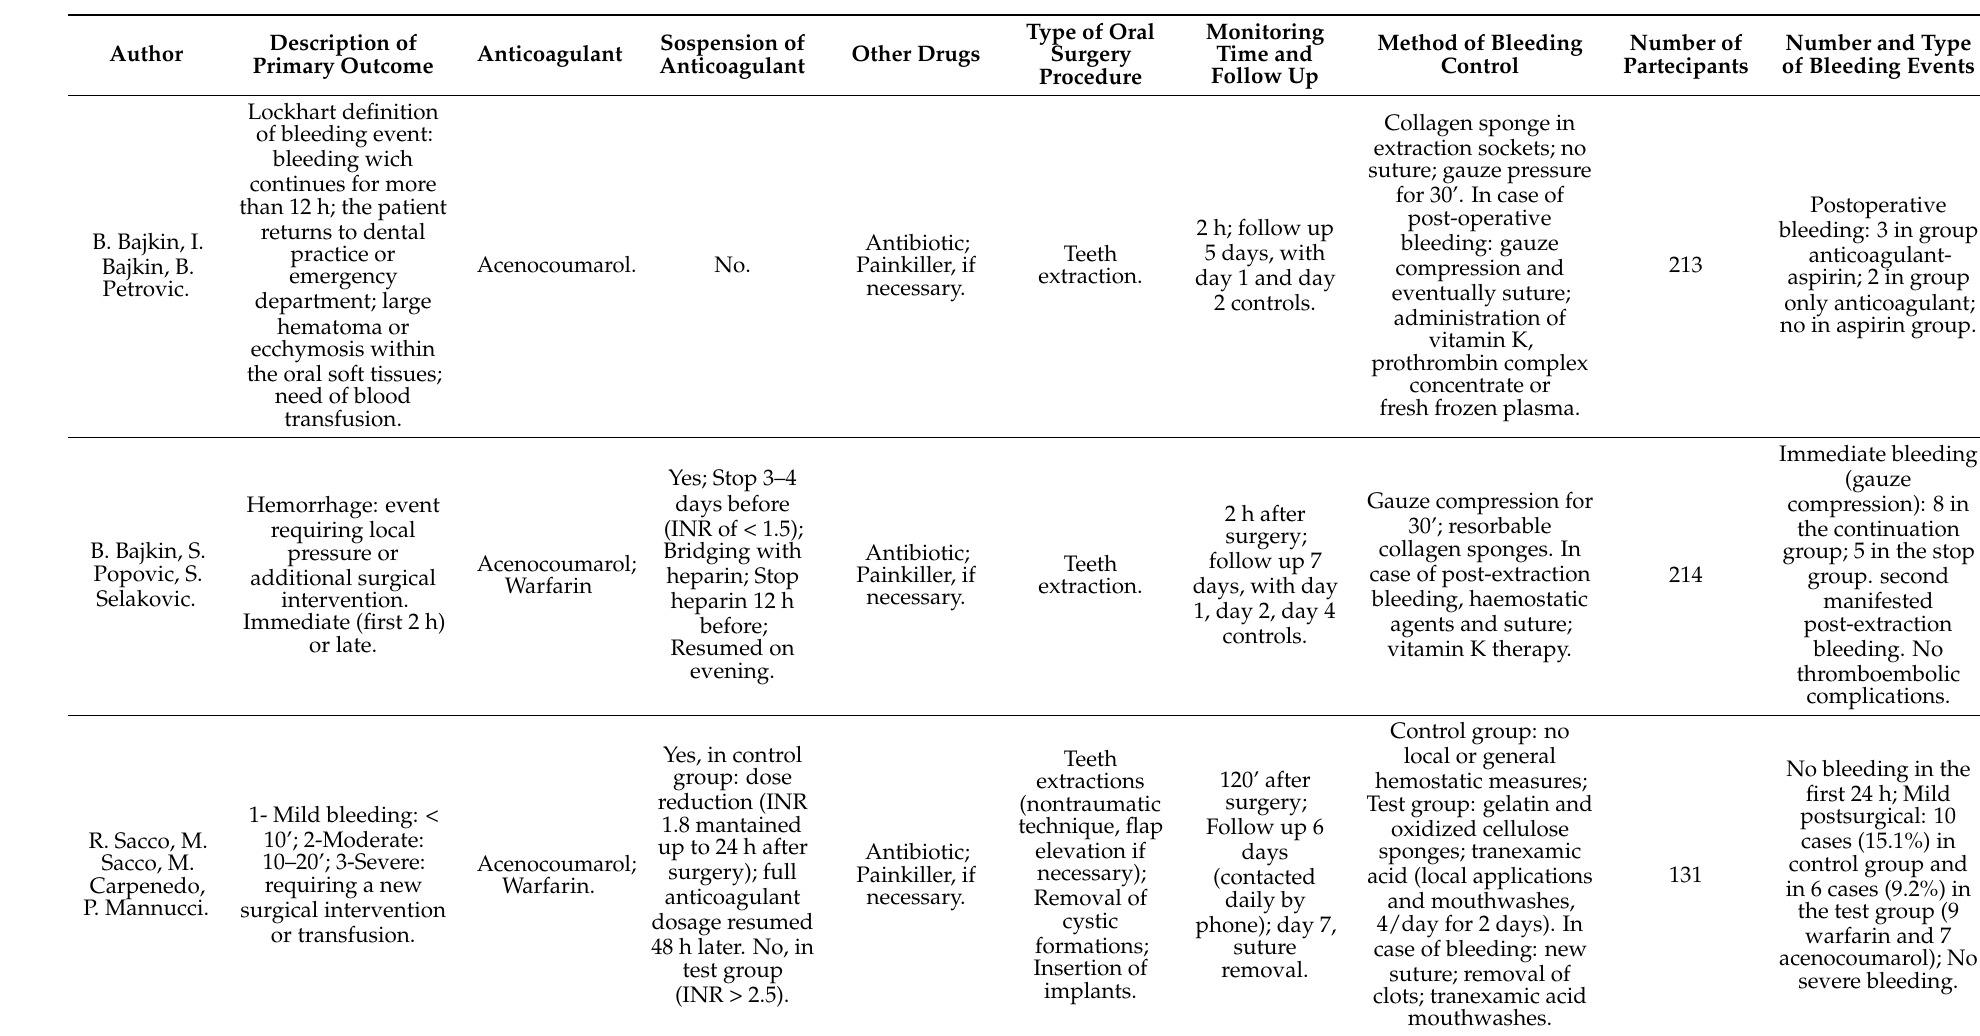
Table 1. Studies considering